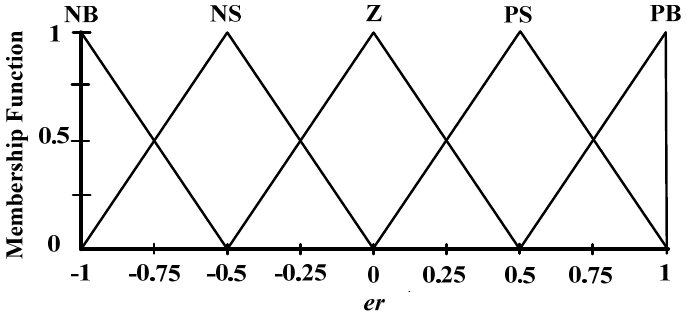
Figure 14. The membership function for input